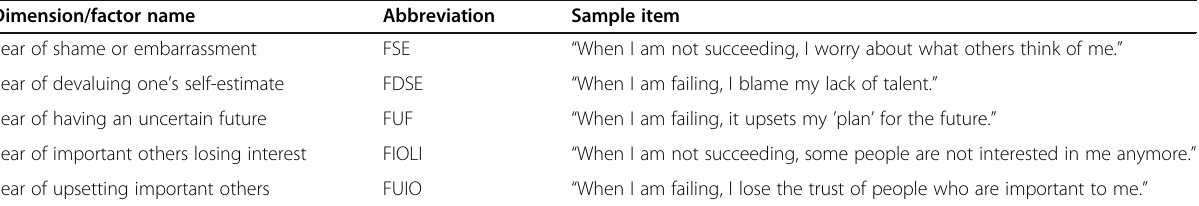
Table 1 Sample items representing the five dimensions of the original PFAI (Conroy et al. 2002) Dimension/factor